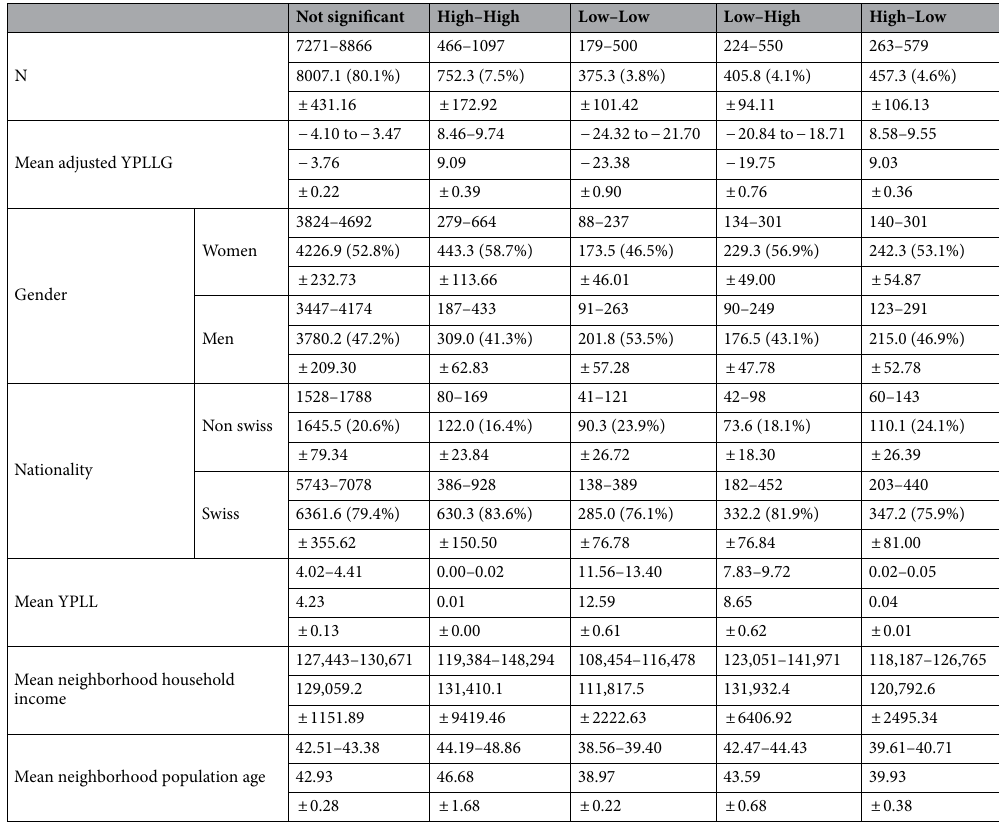
Table 2. Characteristics of individuals within each Local Moran cluster type for the adjusted YPLLG model. For each variable, the table shows range, mean, and standard deviation, calculated across the ten subsets. The totals per category may not be equal to 10,000 due to neighborless individuals who were excluded from the Local Moran’s